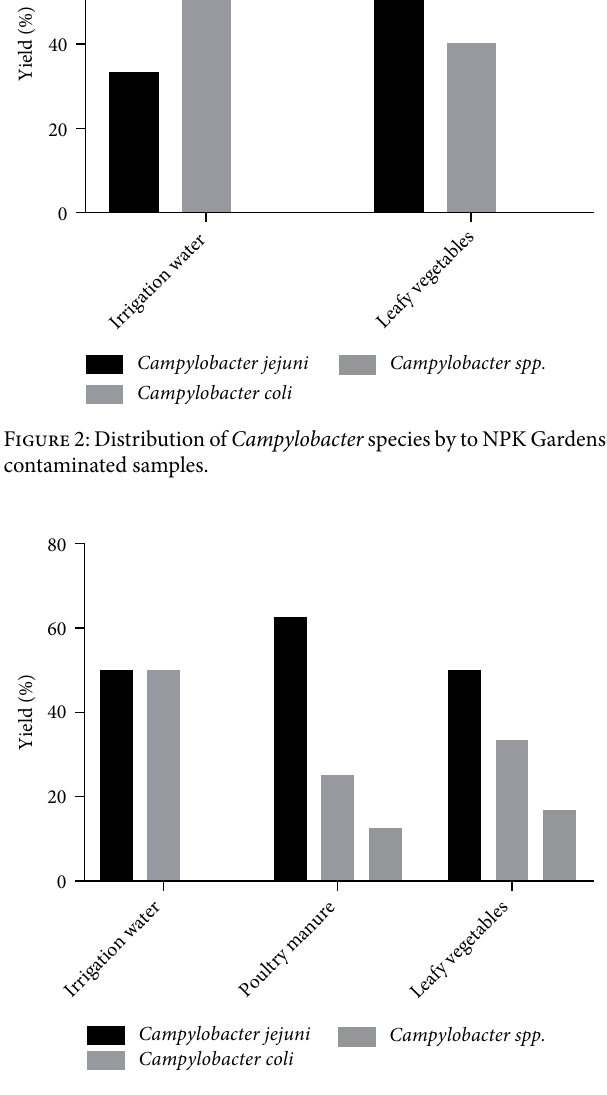
Figure 3: Distribution of Campylobacter species by contaminated samples from gardens using poultry